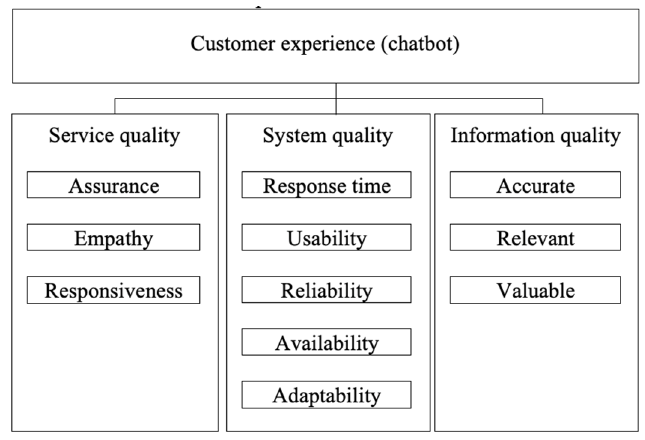
Figure 2. Customer experience and its dimensions by chatbots.